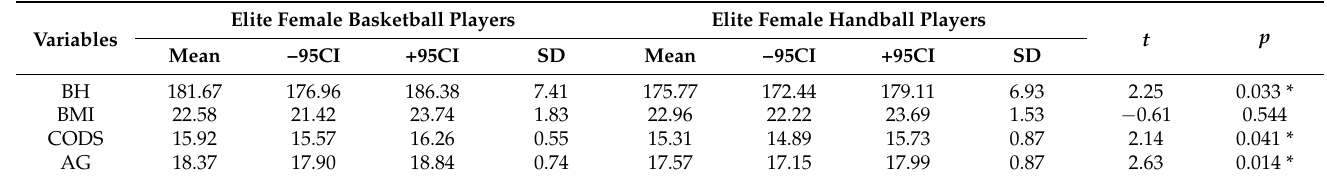
Table 1. Descriptive statistics and independent samples t -Student test results between types of sport ( t -value, p